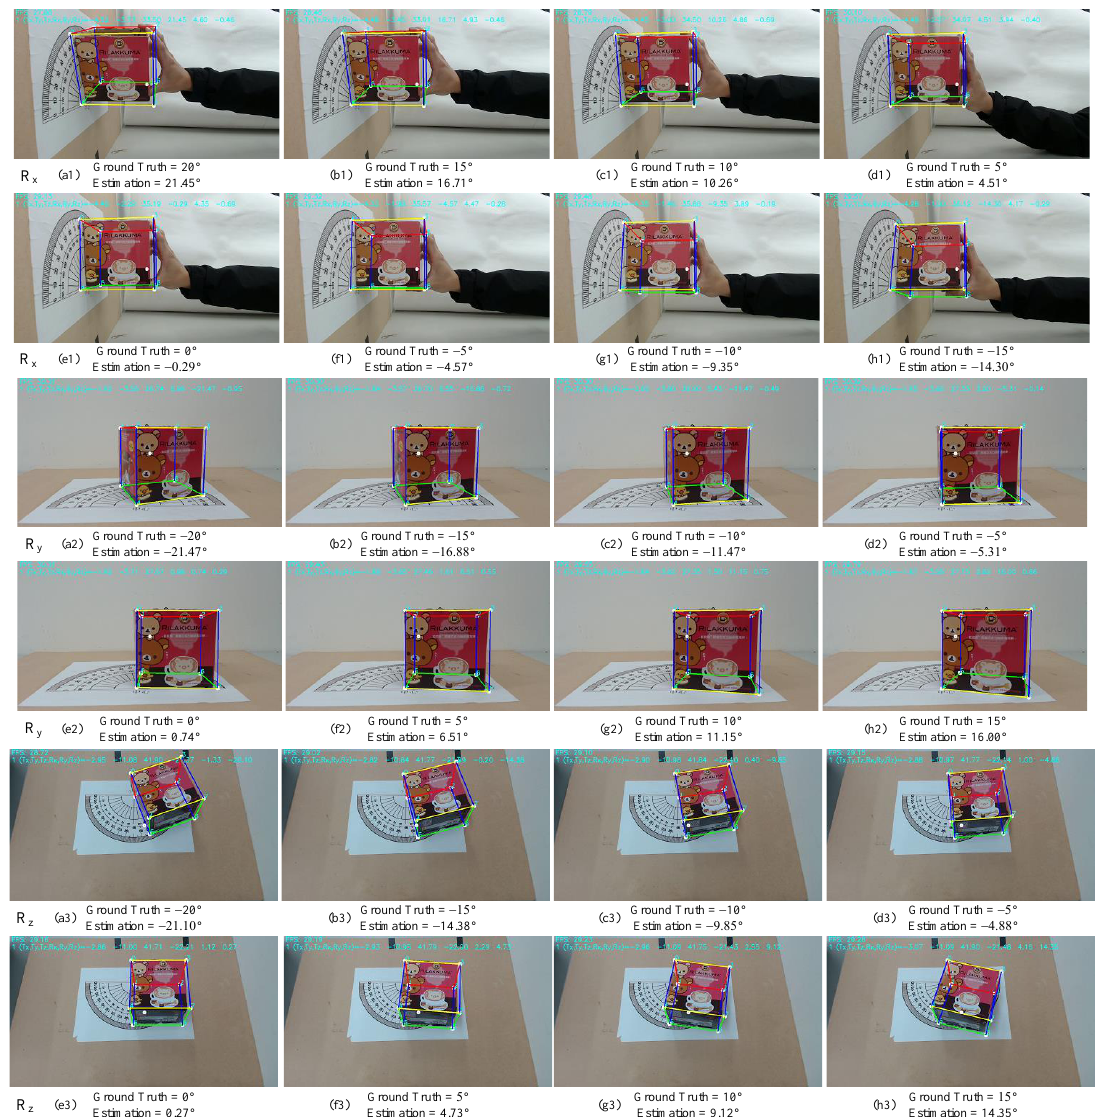
Figure 5. Experimental results of the proposed algorithm to estimate the rotation angles of the ( a1 – h1 ) x -axis, ( a2 – h2 ) y -axis and ( a3 – h3 ) z -axis of the OOI.